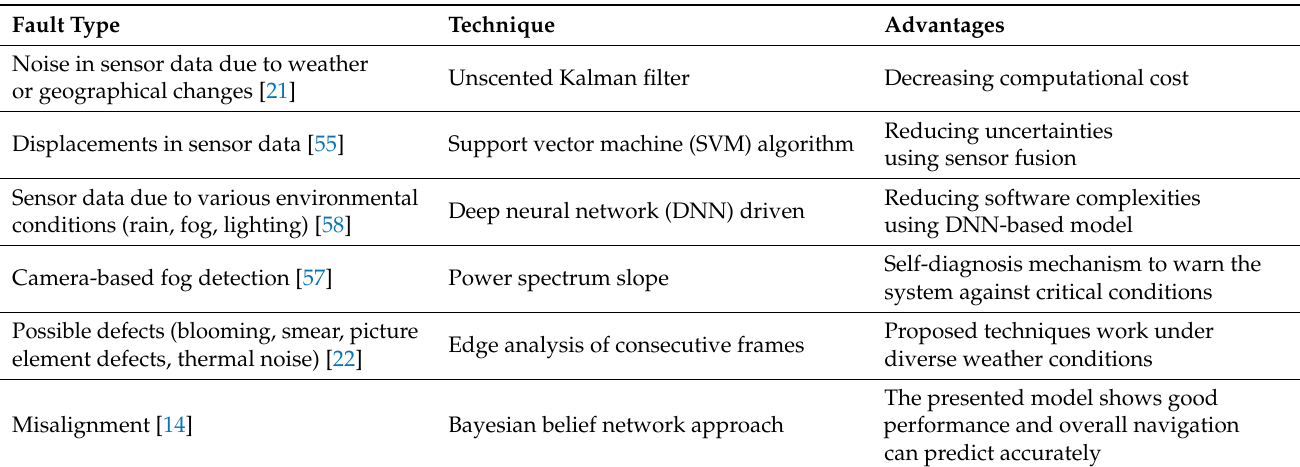
Table 2. Demonstration of fault types and prognostic health management (PHM) analysis for an autonomous vehicle (AV)